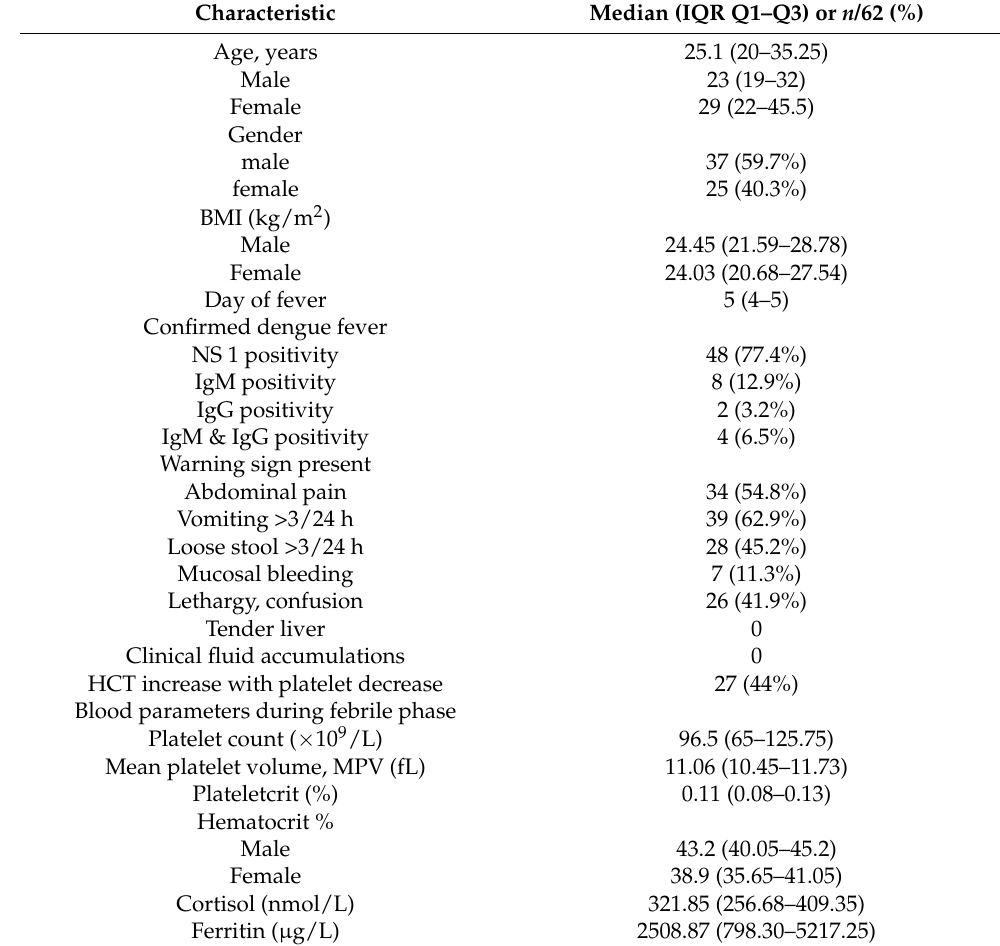
Table 1. Clinical characteristics, platelet indices and biochemical markers of dengue patients with warning signs in febrile phase at TP-1 ( n =